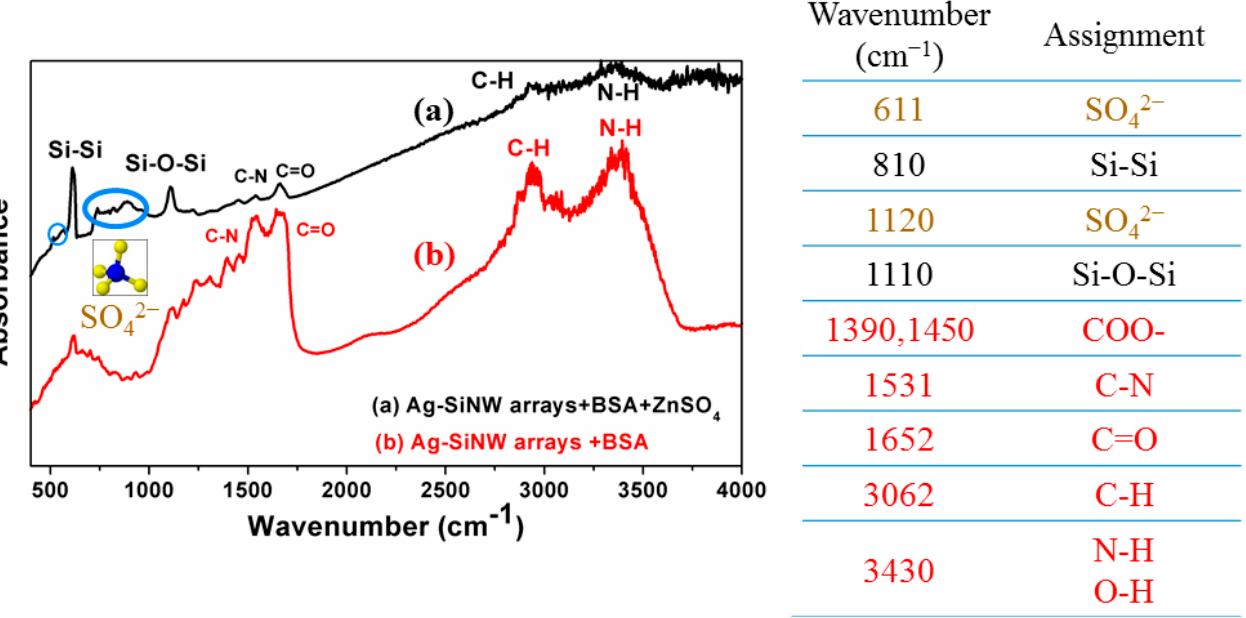
Figure 9. Comparison of FTIR spectra of the Ag–SiNW arrays ( a ) immobilized with BSA and ZnSO 4 (black line) and ( b ) immobilized with BSA (red line).